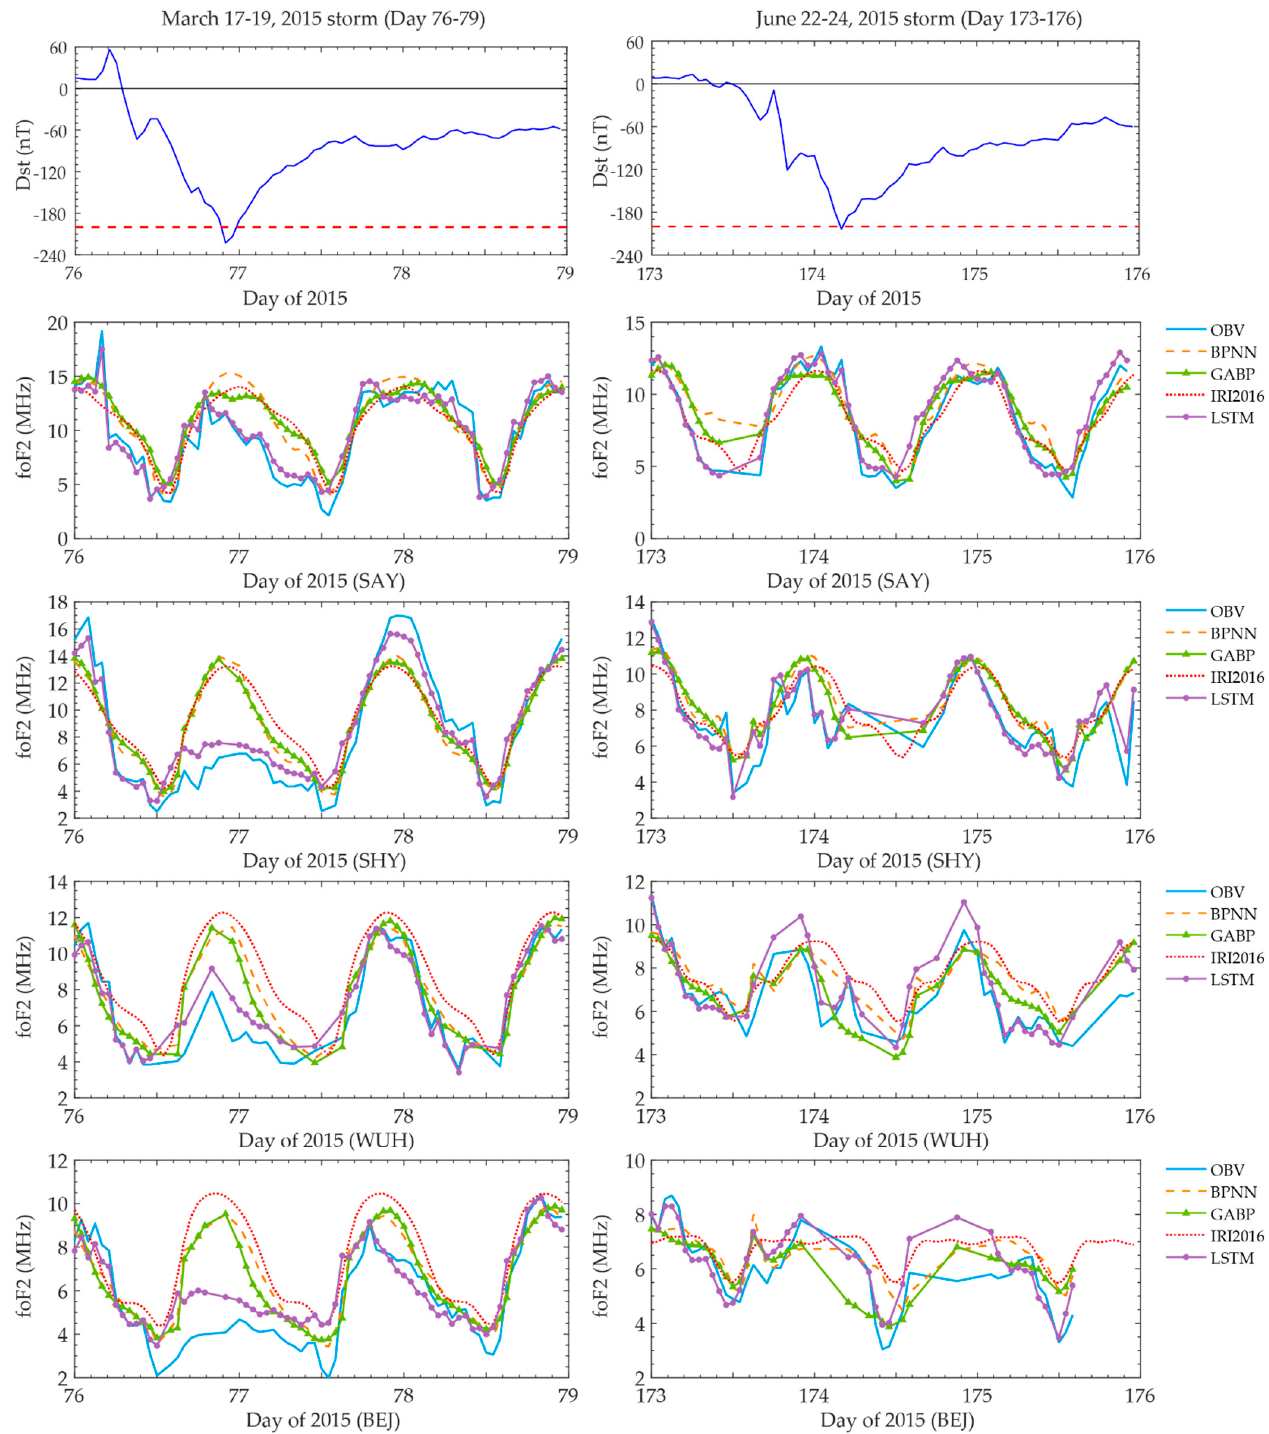
Figure 8. Same as Figure 6, but during storm condition for the year of solar maximum (2015) at days 76–79 and 173–176. The top panels show the variation of the magnetic Dst index during the two storms.